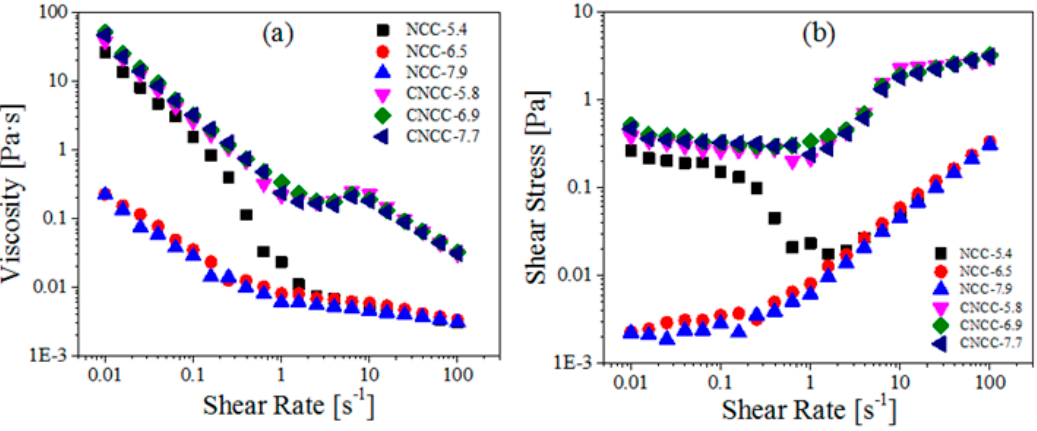
Figure 3. ( a ) Viscosity and ( b ) Shear stress as a function of shear rate for NCC and CNCC suspensions at various pH.